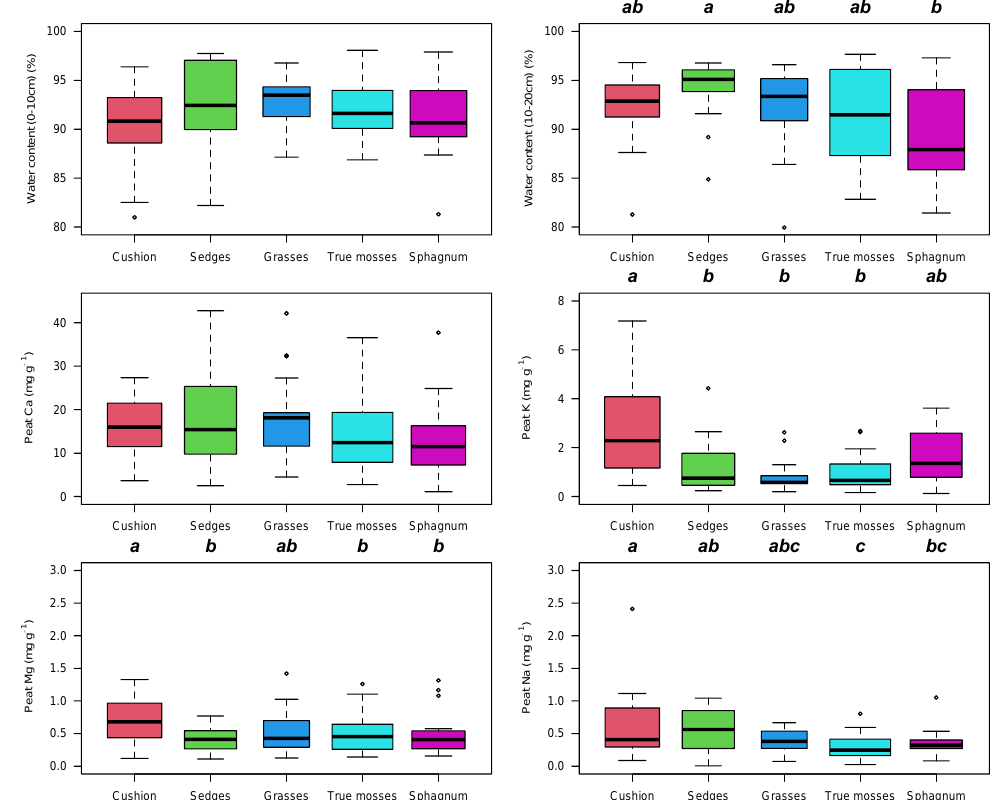
Figure 6. Box and whisker plots for variation in peat water content and peat chemistry for 121 peatlands in the northern Andes. Top row: peat water content as a proportion of the wet peat weight at field capacity subtracting the dry weight. Tukey’s homogeneous groups are marked with the same letter. The circles represent outlier values outside the 95% interval. Plants 2023 , 12 , x FOR PEER REVIEW Cushion-dominated sites had an overall lower impact from human disturbance than the other sites (F 4110 = 21.6, p < 0.001). An additional effect was observed between the intensity of the disturbance and the carbon content for all four vegetation types (F 1112 = 20.16, p < 0.001) (Figure 7).